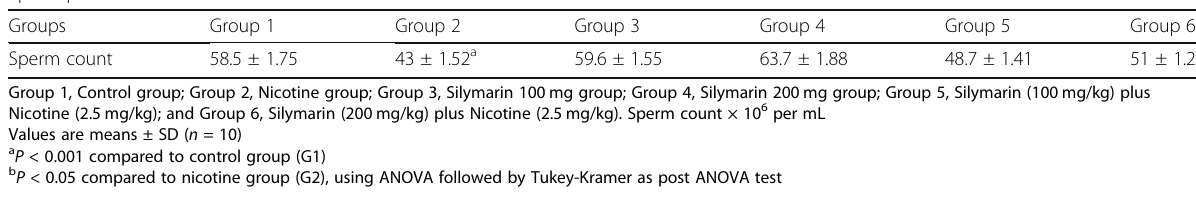
Table 1 Quantitative comparison of sperm count in study groups Sperm parameter